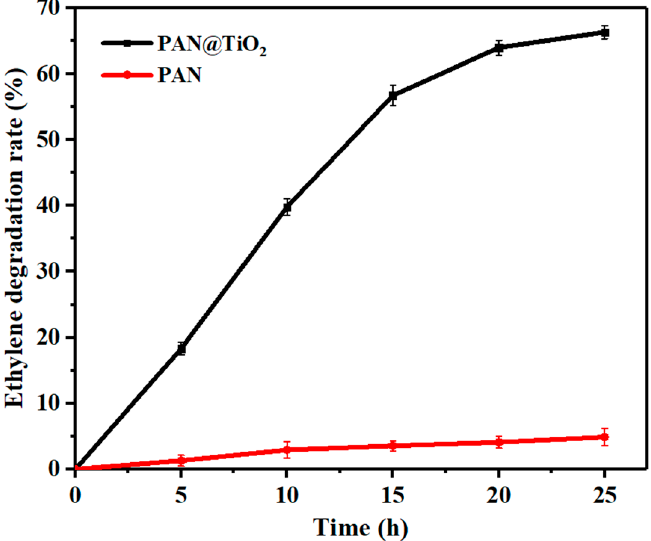
Figure 6. Photocatalytic degradation of ethylene using PAN@TiO 2 nanofibers under UV irradiation. The data represent the means of three independent experiments. The error bars indicate the standard deviation of the mean.